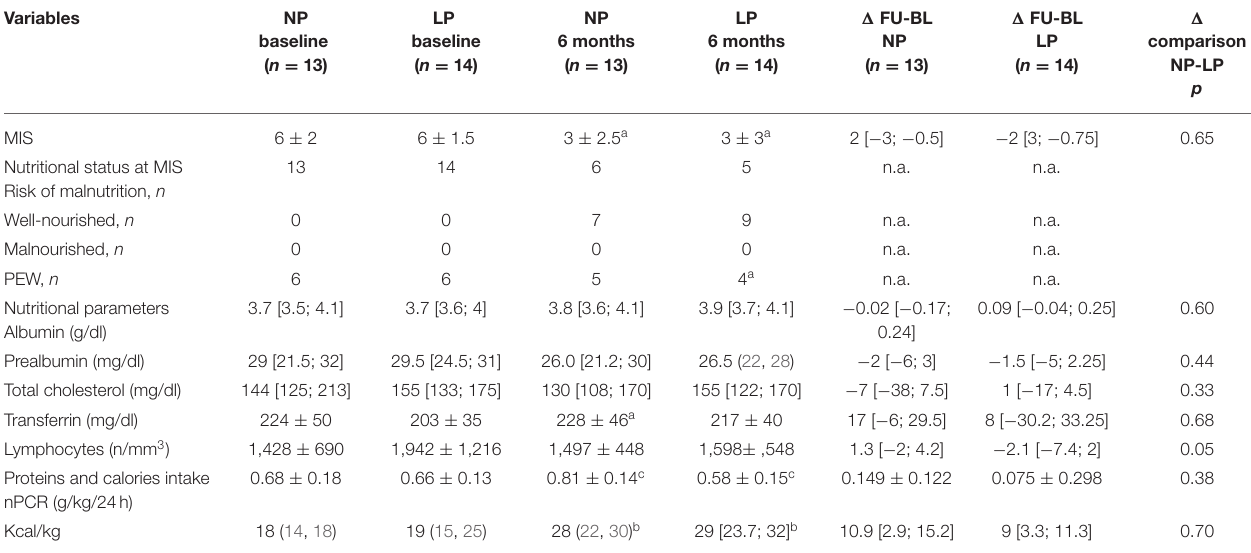
TABLE 2 | Nutritional status and nutritional intake at baseline vs. 6 months.